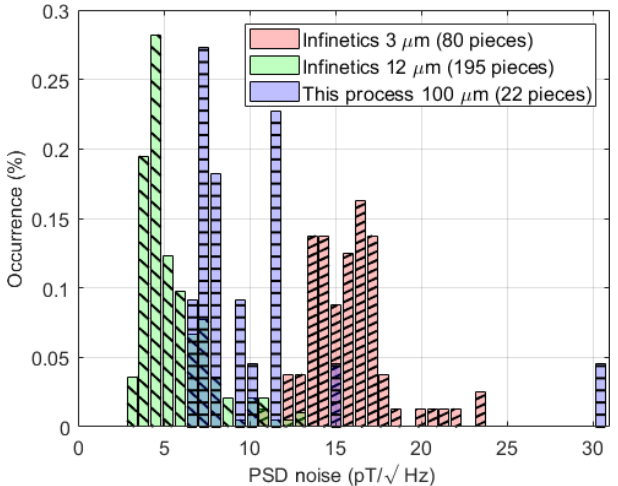
Figure 19. Histogram of ring-core noise (pTHz − 1 / 2 ) at 1Hz. The current process yields 6–11pTHz − 1 / 2 at 1Hz noise performance compared to ∼ 4 for the Infinetics 12µm ring cores and ∼ 16 for the 3µm Infinetics ring